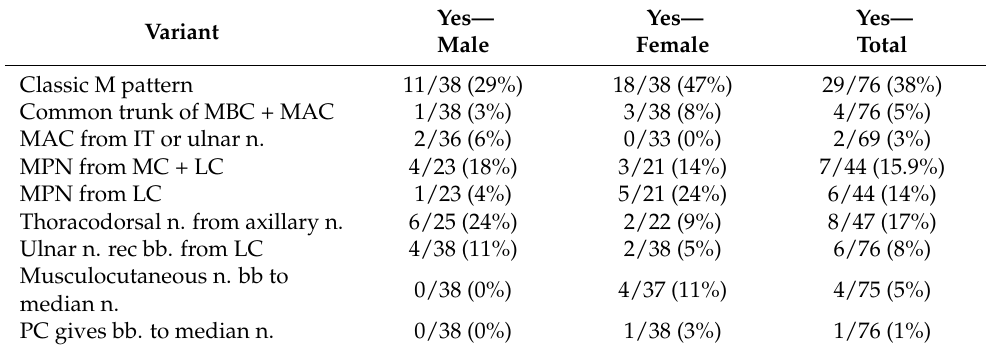
Table 2. True prevalence of brachial plexus branching variants identified in the present study.